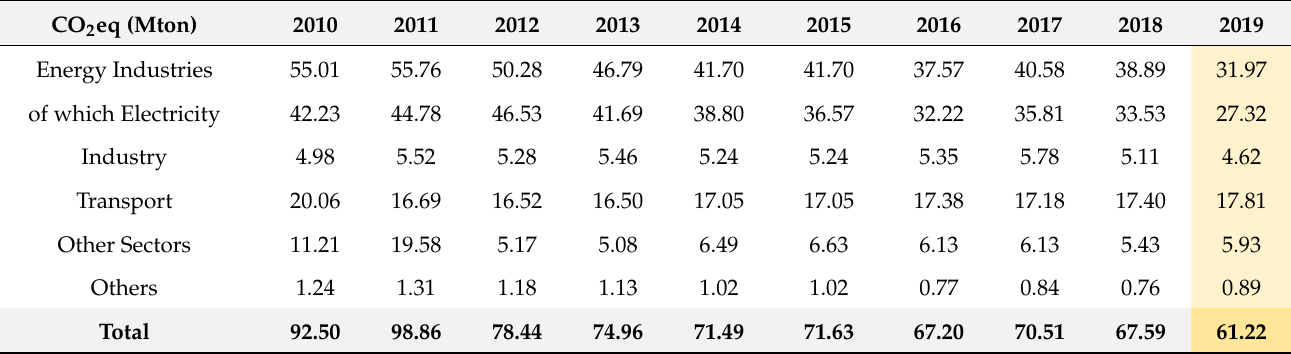
Table 5. Energy Sector (UNFCCC inventory) Emissions.